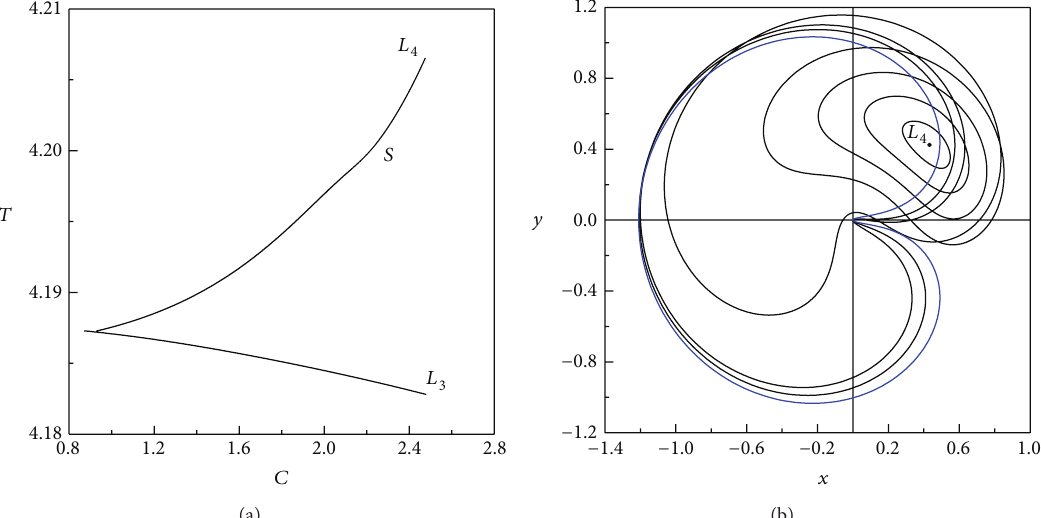
Figure 12: (a) The bifurcation of the short period family with the Lyapunov family emanating from the collinear equilibrium point 𝐿 3 . (b) Typical members of the short period family. The bifurcation orbit is shown